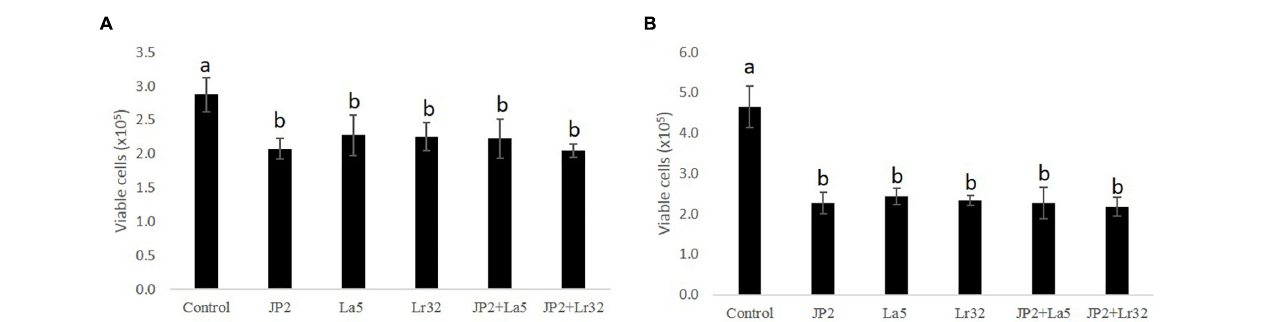
FIGURE 1 | Cell viability determined by trypan blue exclusion in OBA-9 cells mono-infected with A. actinomycetemcomitans (JP2) and/or L. acidophilus La5 (La5) or L. rhamnosus Lr32 (L32) for 2 h (A) and 24 h (B) . Statistical test: ANOVA/Tukey, different letters mean p < 0.05. In the y-axis is the number of viable OBA-9 cells (x10 5 ). Control corresponds to non-infected